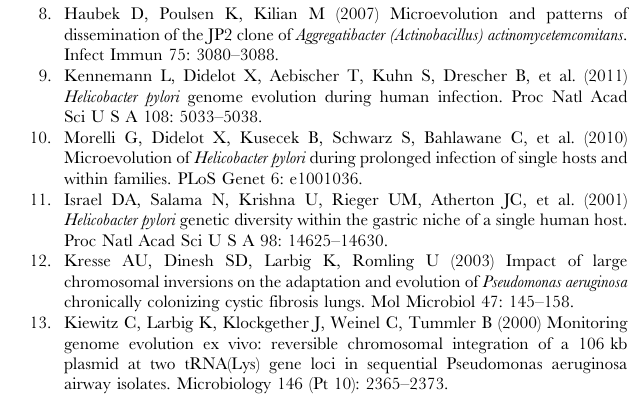
Figure S3 Strategy for confirmation of a plasmid-homologous region in the genome of strain S23A. The figure is drawn to scale. The arrows depict the direction and location of the contigs. The black lines above the scaffolded contigs represent the regions amplify by PCR. The sequences of the joint regions between the genome and plasmid-homologous regions were determined as needed. The vertical dash lines identify the boundary of the approximately 14 Kb plasmid-homologous regions. Noted that the contigs flanking the plasmid-homologous region contain both plasmid-homologous and non-plasmid sequences. (PDF) Figure S4 Sequence comparison of the region of the 2,293 bp deletion in SCC2302 and the intact sequence in the sibling strain AAS4a. The deleted region that occurred in SCC2302 is underlined. The 2,293-bp deletion led to a truncation of 906 bp in the C-terminus of a 1,302-bp gene encoding oxaloacetate decarboxylase, and the deletion of downstream genes of two hypothetical proteins and a bacteriophage Mu GP27-like protein. Table S1 Genomic islands of the paired strains. Table S2 Signals of comparative genomic hybridization by microarray. Table S3 Primer sequences. Table S4 Cluster ID and product of the 150 core genes used for phylogenetic analysis of A. actinomycetemcomitans . Table S5 PCR analysis of genes of disparity of the paired strains. Table S6 Annotations of the genes found on the plasmid S23A. Table S7 Comparative transcriptome analysis of paired